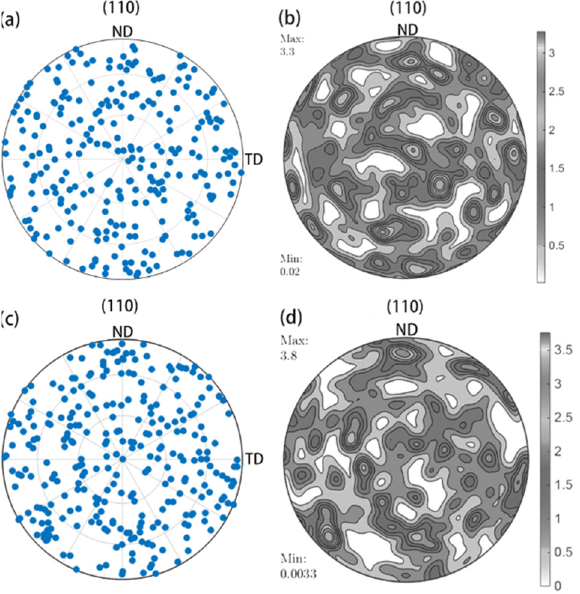
Figure 18. Pole figures of the thread rolling: ( a , b ) before simulation deformation; ( c , d ) after simulation deformation.